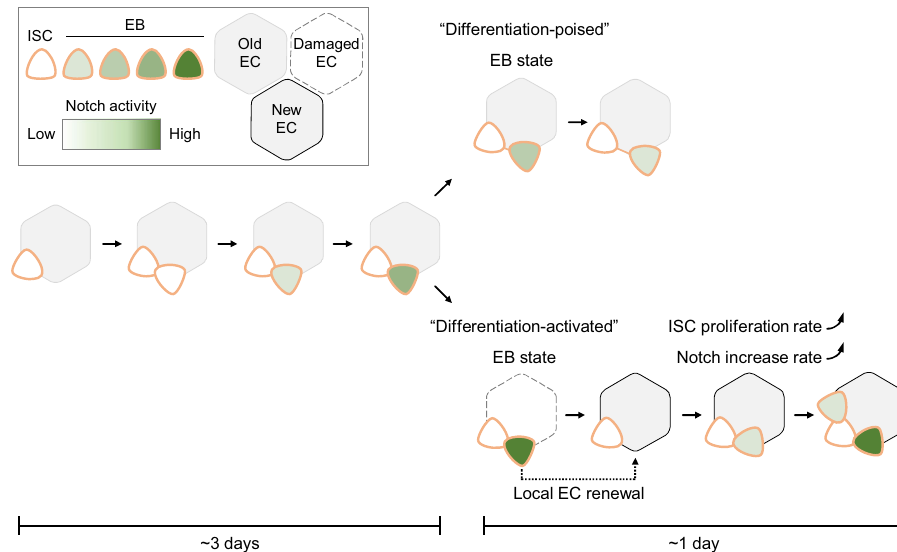
Fig. 7 Model of physiological dependence of EB differentiation in the Drosophila intestines. The fi gures from the left side to the right, show an ISC that is divided once generating one self-renewal ISC and one EB with the activated Notch signaling. Notch signaling gradually increased in this EB in the intestines of young and healthy fl ies. This process could take more than 3 days. Later on, there were two distinct EB statuses depending on the local physiology: (1) A “ differentiation-poised ” EB status, corresponding to no EC damage nearby. Notch activation in this “ differentiation-poised ” EB could be even decreased due to the detachment from the ISC. (2) A “ differentiation-activated ” EB status, corresponding to a damaged EC nearby. ISC proliferation and Notch activation in EBs were dramatically increased. The local EC renew could be thus achieved in less than one